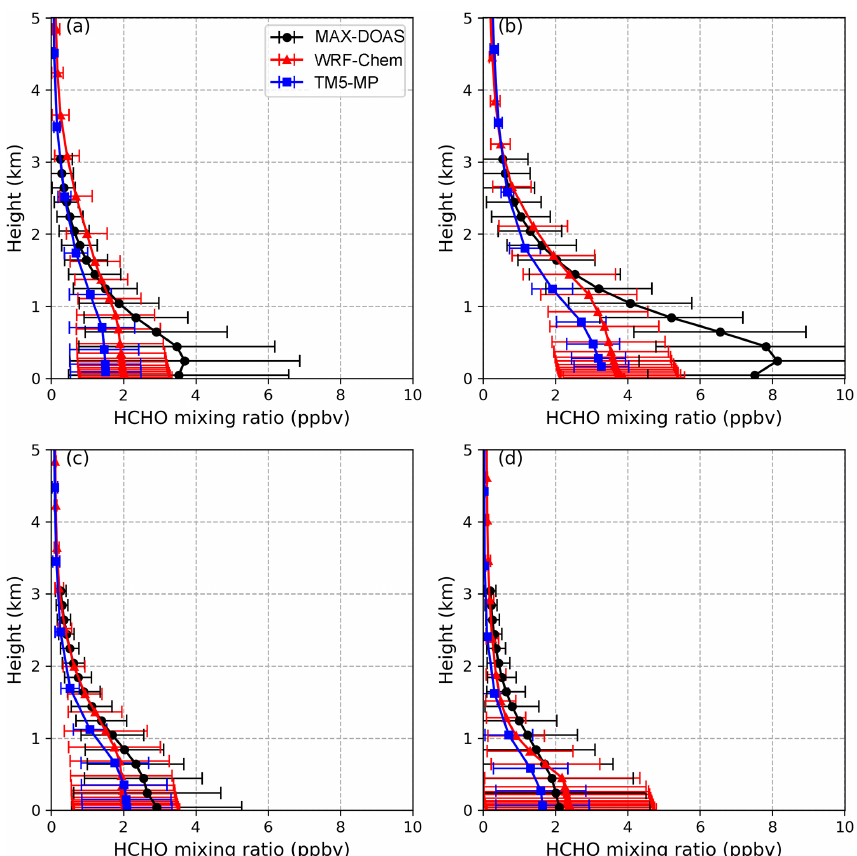
Figure 7. Seasonal average of vertical HCHO profiles obtained from MAX-DOAS, WRF-Chem and the TM5-MP model in spring (a) , summer (b) , autumn (c) and winter (d) at the CAMS site. The error bars represent 1 σ standard deviation of